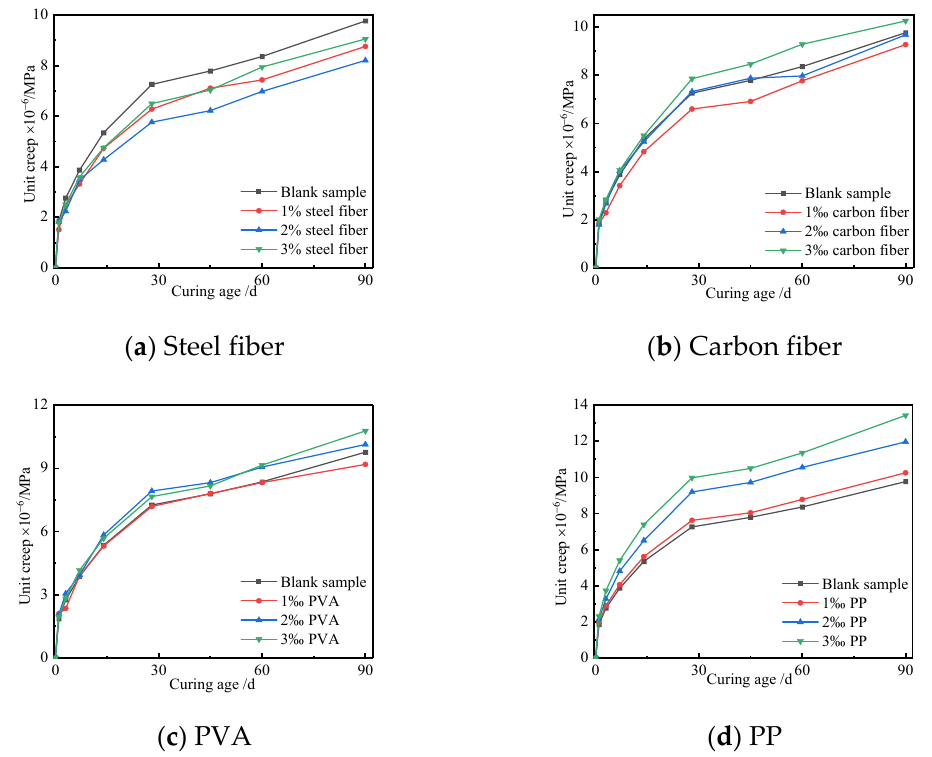
Figure 13. Unit creep curves of the UHPC with different types and contents of fibers.